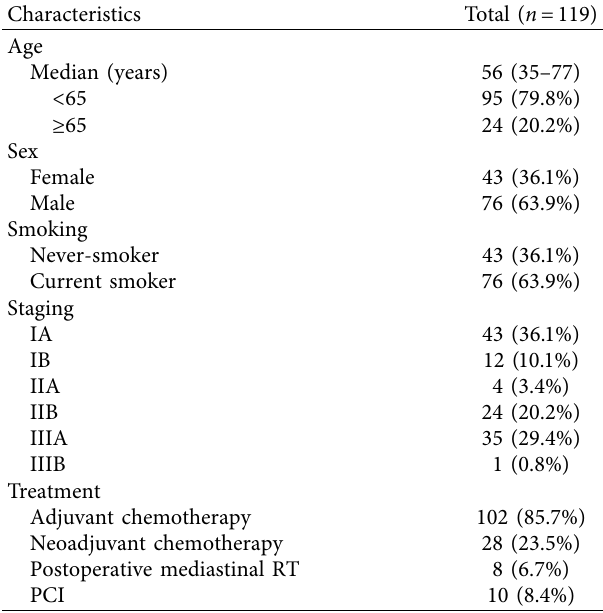
Table 1: Clinicopathological and treatment characteristics.